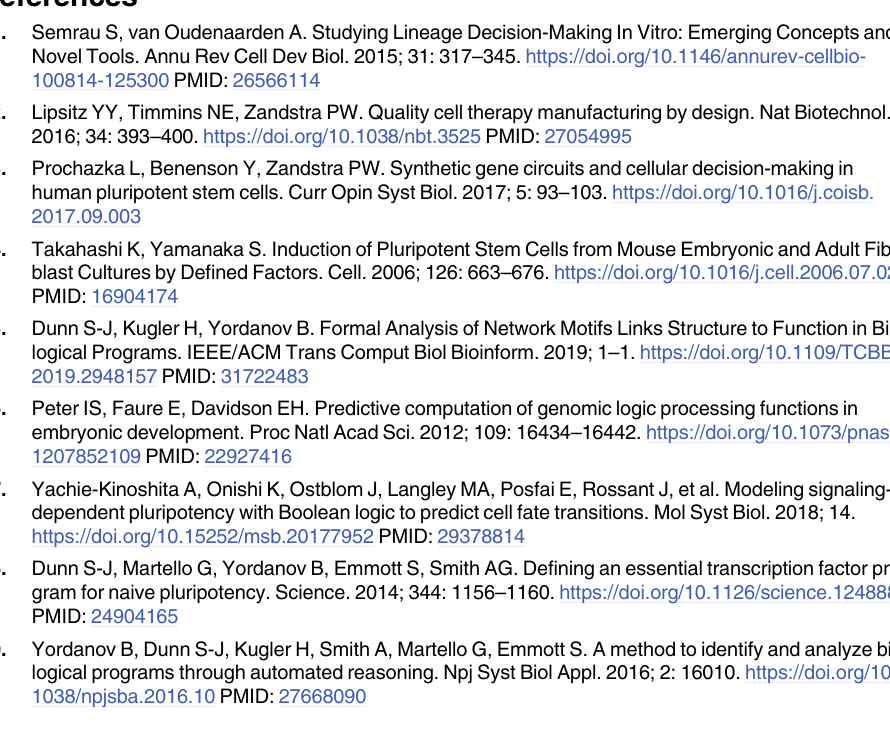
S5 Table. The final gene list and provisional logical GRN for erythropoiesis.